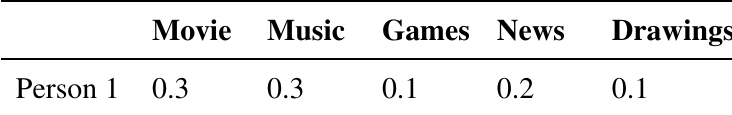
Table 3. Prior score of a person for different